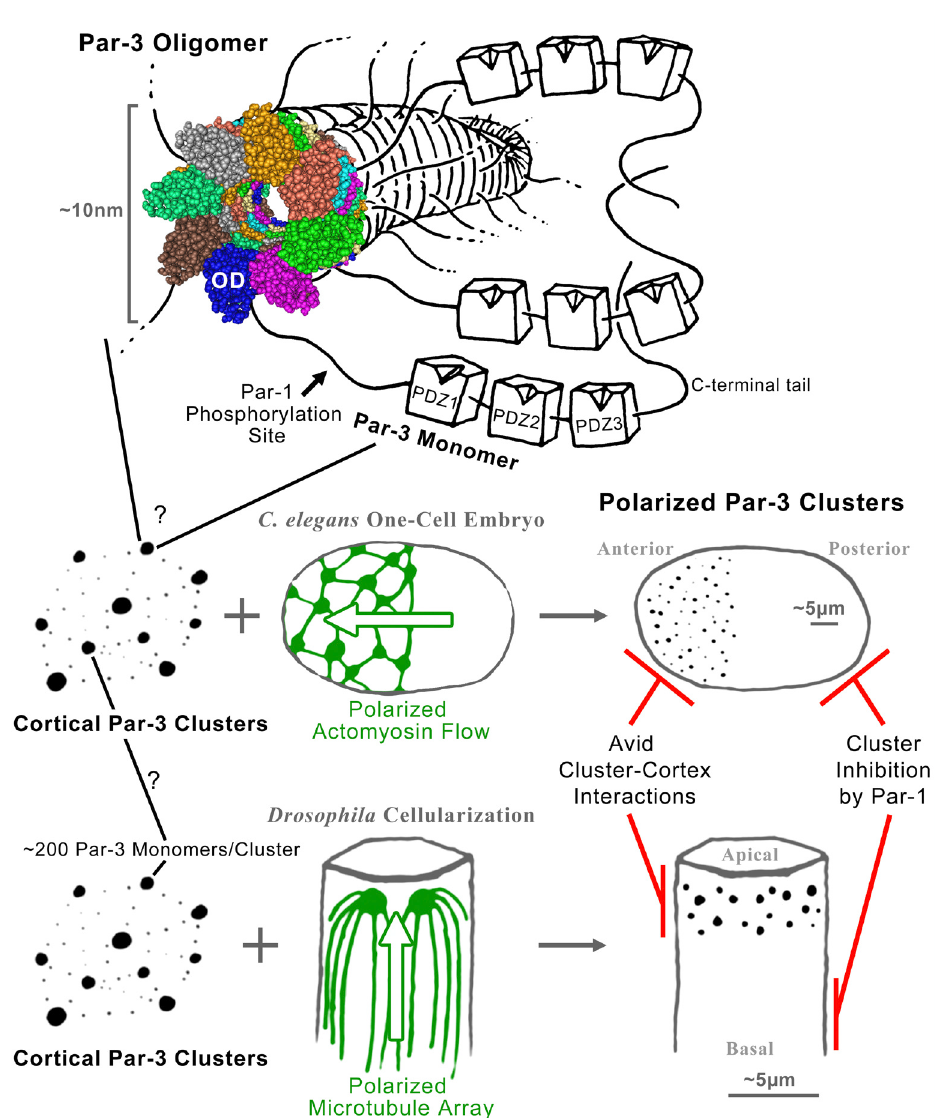
Figure 1. The organization and polarization of Par-3 clusters. The oligomerization domain of a Par-3 monomer mediates the formation of a helical fiber from which the linker regions and PDZ domains of Par-3 would emanate like branches of a tree. The space-filling structural model is a Cn3D view of the model of Zhang et al. (PDB: 3ZEE) 14 . Somehow these fibers are organized into local Par-3 clusters scattered across the cell cortex. In the Caenorhabditis elegans one-cell embryo, a polarized actomyosin flow sweeps the Par-3 puncta to one pole, forming the anterior end of the embryo. In the cellularizing Drosophila embryo, a polarized microtubule array positions the Par-3 puncta to one end of each cell, forming the apicolateral domain. Once the polarity of Par-3 clusters is established, it can be maintained by avid interactions between the clusters and the cell cortex combined with inhibition of Par-3 complex formation at the opposite pole by Par-1 phosphorylation. See main text for further details.